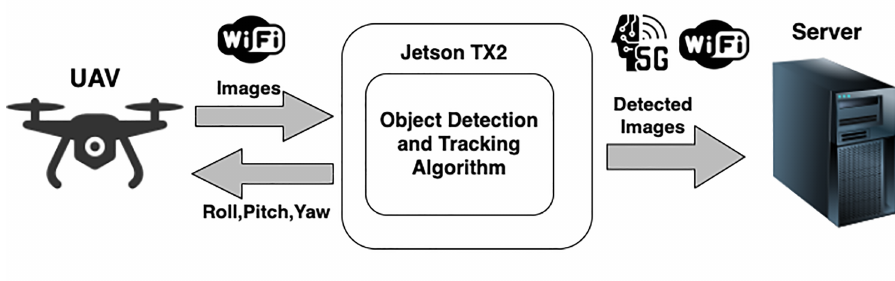
Figure 2. The proposed system architecture.